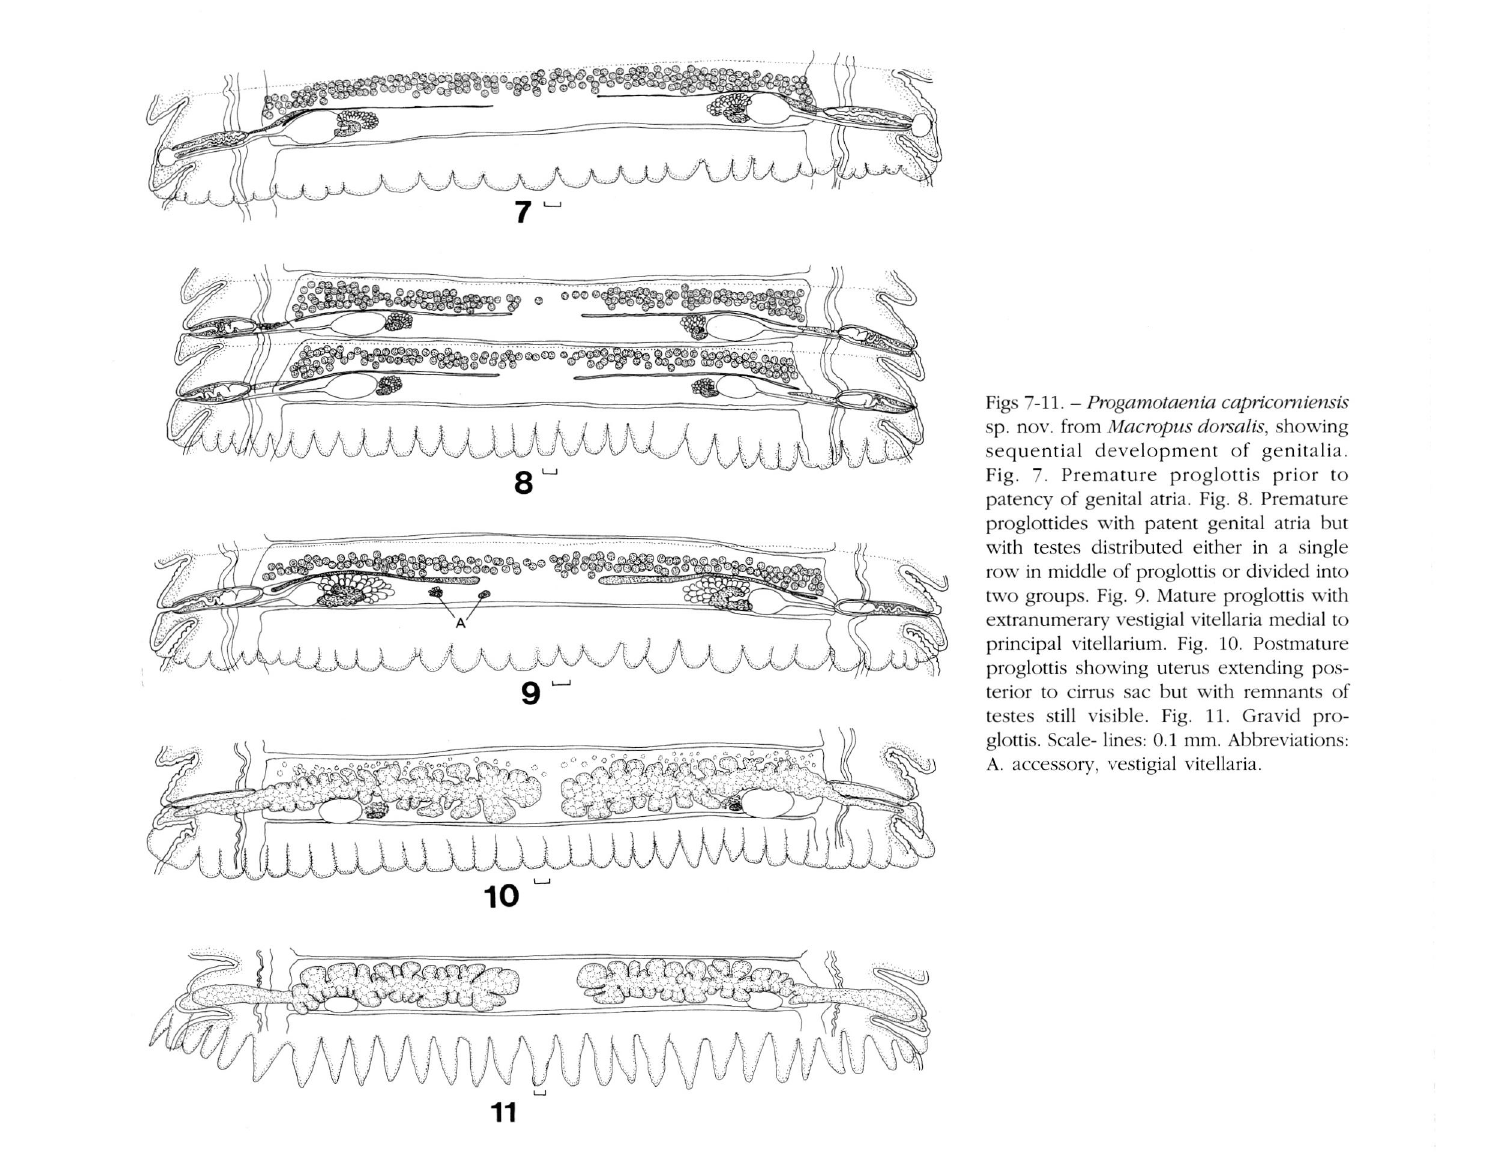
Figs 7-11. - Progamotaenia capricorniensis sp. nov. from Macropus dorsalis, showing sequential development of genitalia. Fig. 7. Premature proglottis prior to patency of genital atria. Fig. 8. Premature proglottides with patent genital atria but with testes distributed either in a single row in middle of proglottis or divided into two groups. Fig. 9. Mature proglottis with extranumerary vestigial vitellaria medial to principal vitellarium. Fig. 10. Postmature proglottis showing uterus extending pos terior to cirrus sac but with remnants of testes still visible. Fig. 11. Gravid pro glottis. Scale- lines: 0.1 mm. Abbreviations: A. accessory, vestigial